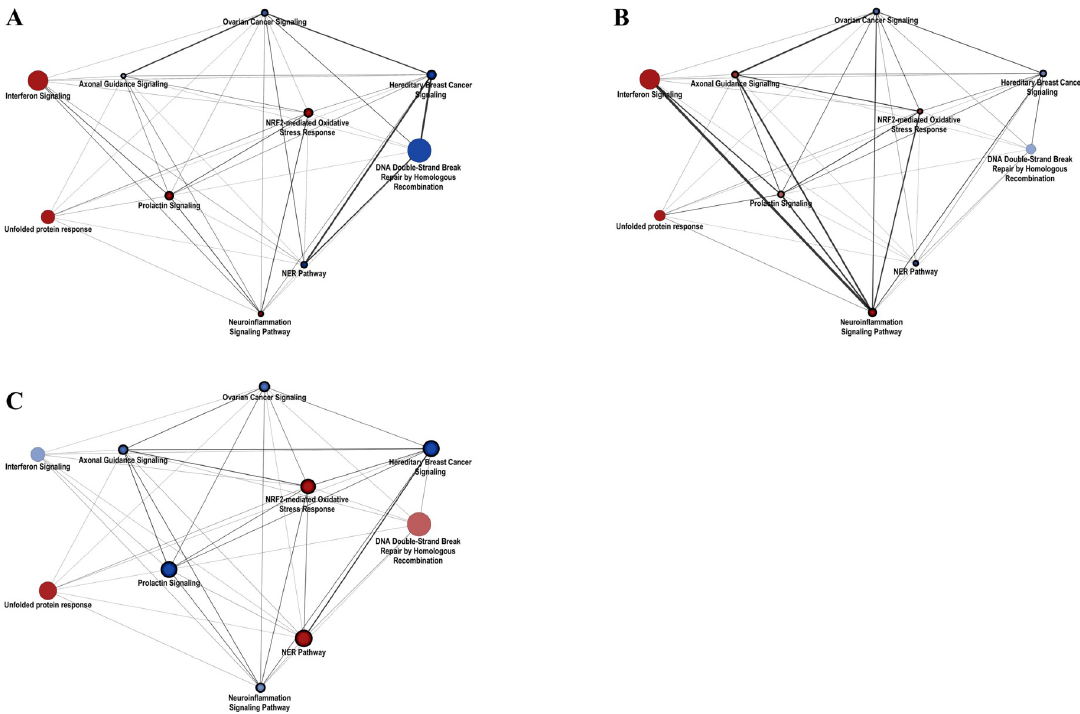
Fig 3. Differential changes in pathway networks among neuronal cells and myeloid dendritic cells. Protein-protein interactions were grouped by significantly expressed biological pathways in hPNs (A), hNCCs (B), and mDCs (C). The nodes represent biological pathways, and node size depends on the betweenness centrality score calculated by network analysis. Edges were generated based on interactions of DEGs contained in pathways. (A) The network with significantly expressed pathways (B) The network with significantly expressed pathways in hNCCs (C) The network with significantly expressed pathways in mDCs. Red: upregulated pathways; blue: downregulated pathways. The networks were generated using Cytoscape v3.7.0 software.